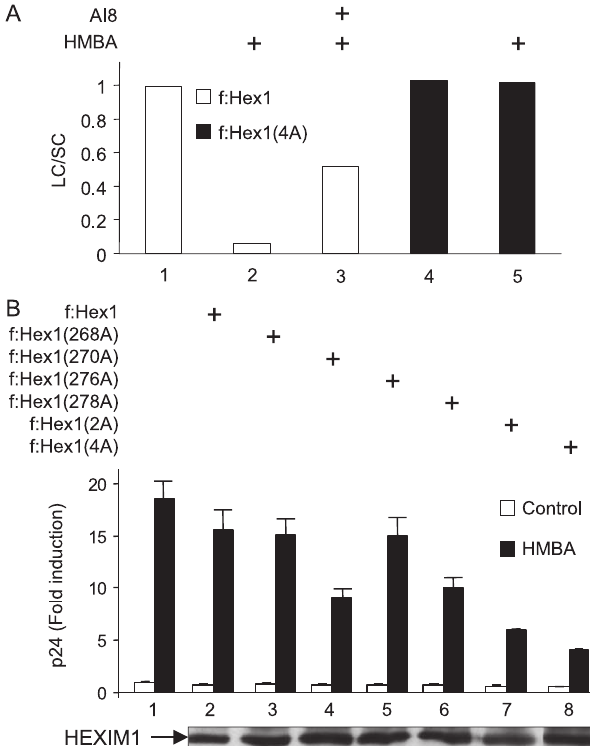
Figure 7. Mutation of the Conserved Threonines and Serines Renders HEXIM1 Insensitive to HMBA Treatment and Antagonizes the Induction of HIV Production by HMBA (A) Jurkat cells were transfected with plasmids expressing wild-type f:Hex1 or mutant f:Hex1(4A) proteins and then stimulated or not with HMBA (5 mM) for 1 h in the presence or absence of AI8 (1 l M). Total lysates were then subjected to glycerol gradient sedimentation and fractions were analyzed as in Figure 2. Western blot was performed using anti-Flag antibodies and the ratio LC/SC measured as in Figure 1. (B) U1 cells were transfected with an empty plasmid vector or those expressing mutant f:Hex1, f:Hex1(2A), f:Hex1(4A), f:Hex1(268A), f:Hex1(270A), f:Hex1(276A), or f:Hex1(278A) proteins. After 24 h, cells were stimulated or not with HMBA (5 mM), supernatant collected after another 24 h, and virus quantified using p24 ELISA.